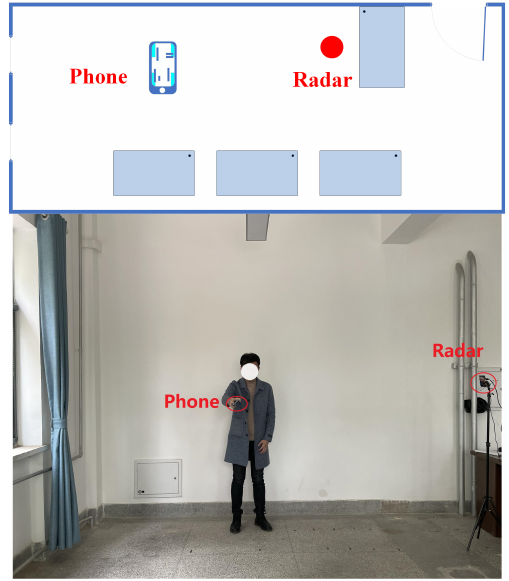
Figure 11. Experimental environment.